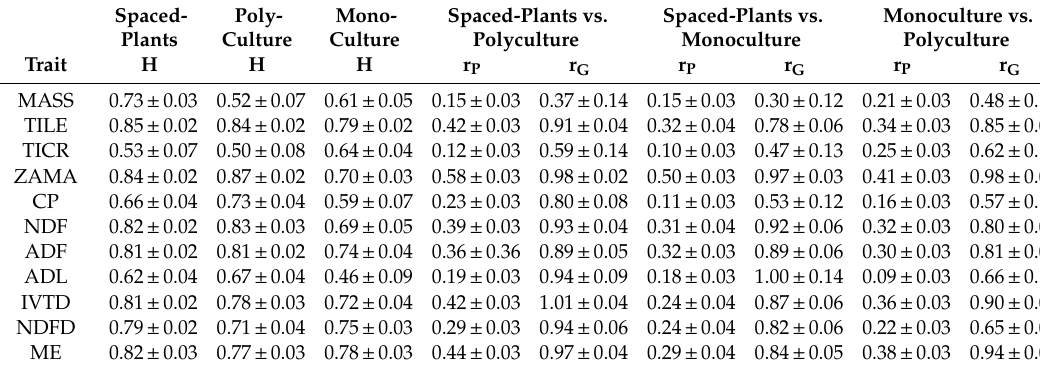
Table 3. Broad-sense heritabilities ( H ), and phenotypic (r P ) and genoptypic (r G ) correlations between three competition environments for 192 clonally replicated, full-sib progeny (genets) of the M26 × M35 intermediate wheatgrass mapping population evaluated over two years (2016–2017) at Logan, UT,